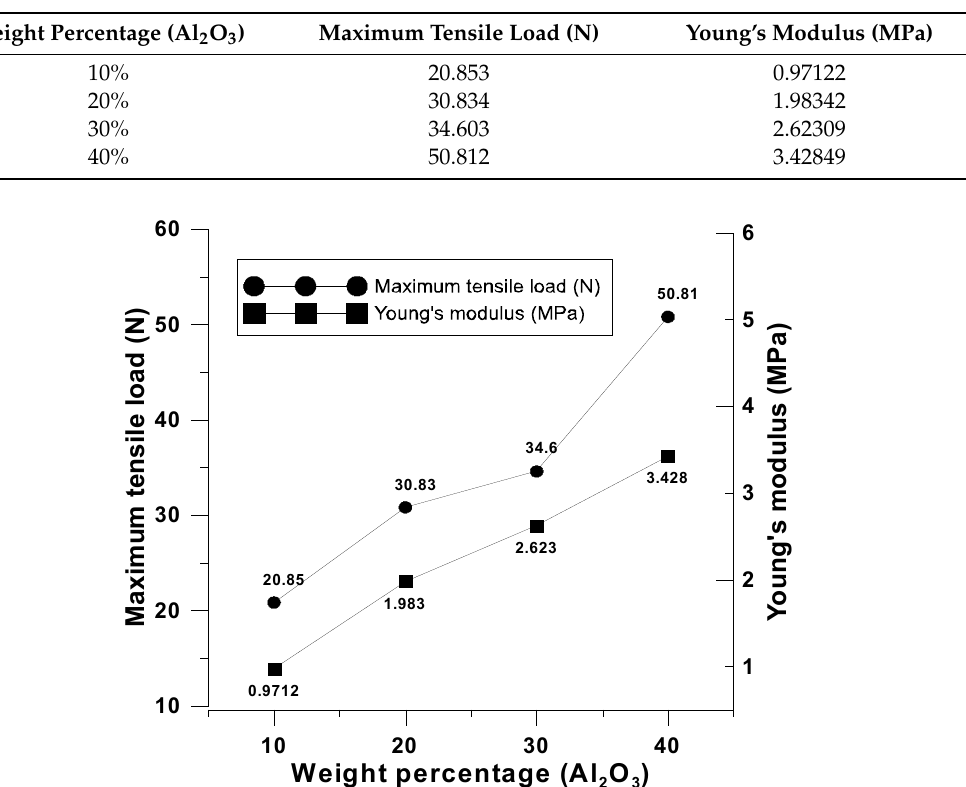
Figure 8. Influence of the Weight Percentage of Alumina Powder on Maximum Tensile Load and Young’s Modulus.